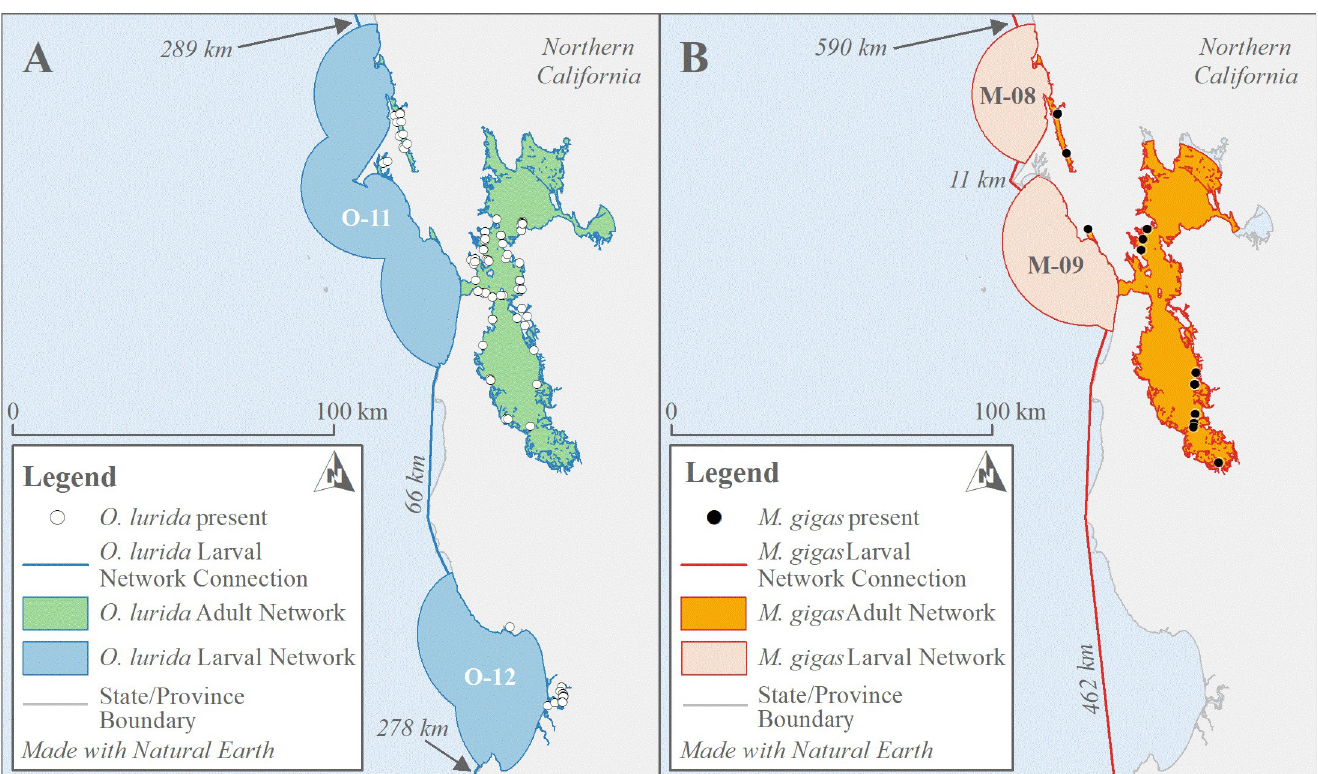
Fig 2. Oyster distribution networks. Examples of oyster larval and adult networks and larval optimal network connections from the San Francisco Bay area (Northern California) for O . lurida (A) and M . gigas (B). For O . lurida , the distance between the San Francisco Bay larval network (O-11) and the next closest network to the south (O-12) is due to oysters present in the Monterey Bay area, which is a shorter distance than for M . gigas , for which the next closest adults to the south (contained within network M-10, not pictured) are in Southern California.